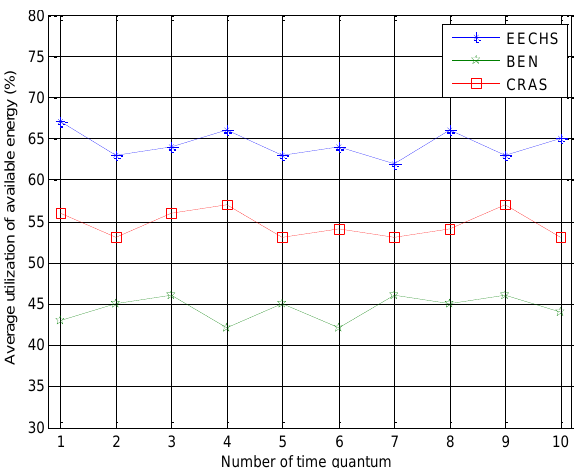
Figure 9. Experimental results for the average utilization of available energy from the